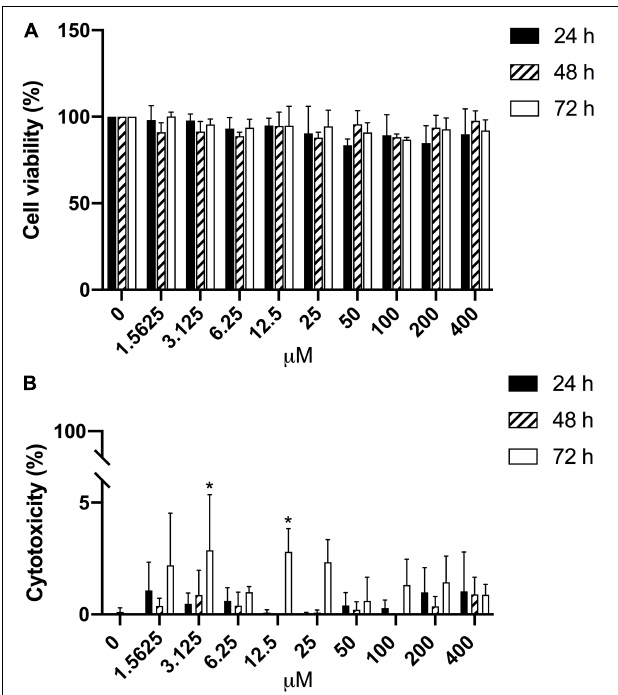
FIGURE 4 | Negligible effects of CBS on HGECs. HGECs were treated with different concentrations of CBS for 24, 48, and 72 h, respectively. Cell viability and cytotoxicity were analyzed, with reference to the untreated group (0 µ M). (A) Cell viability results from MTT test. No significant difference was found among different groups. (B) Cell cytotoxicity results from LDH test. * P < 0.05. Data represent the mean ± SD of three independent